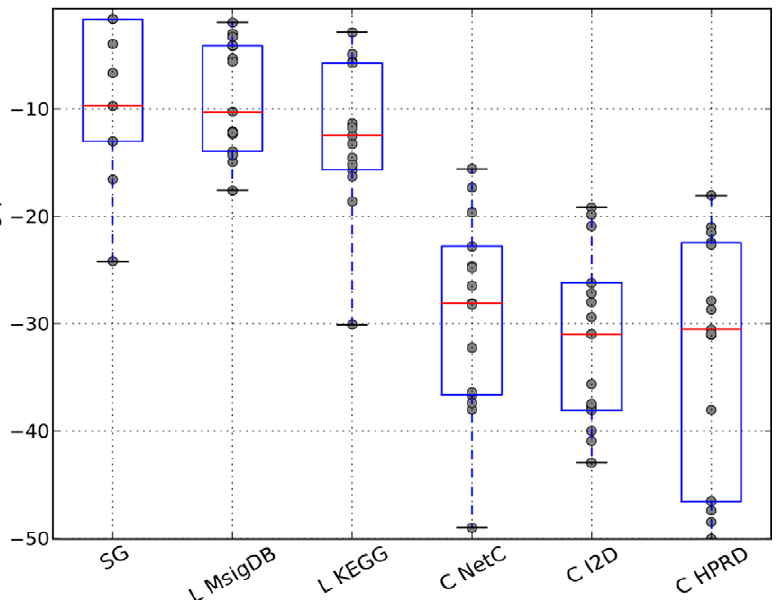
Figure 8. Feature stability when the top 50 features are selected. For each method the Fisher exact test was employed to compute a p-value representing the overlap between the gene sets extracted from two different data sets. This was repeated for all pairwise combinations of data sets, resulting in 15 values. It should be noted that we do not employ the Fisher exact test as a hypothesis test. Instead we interpret the p-values as a measure of overlap between two sets of marker genes. The figure shows the box plots for each method and the individual values (grey dots).